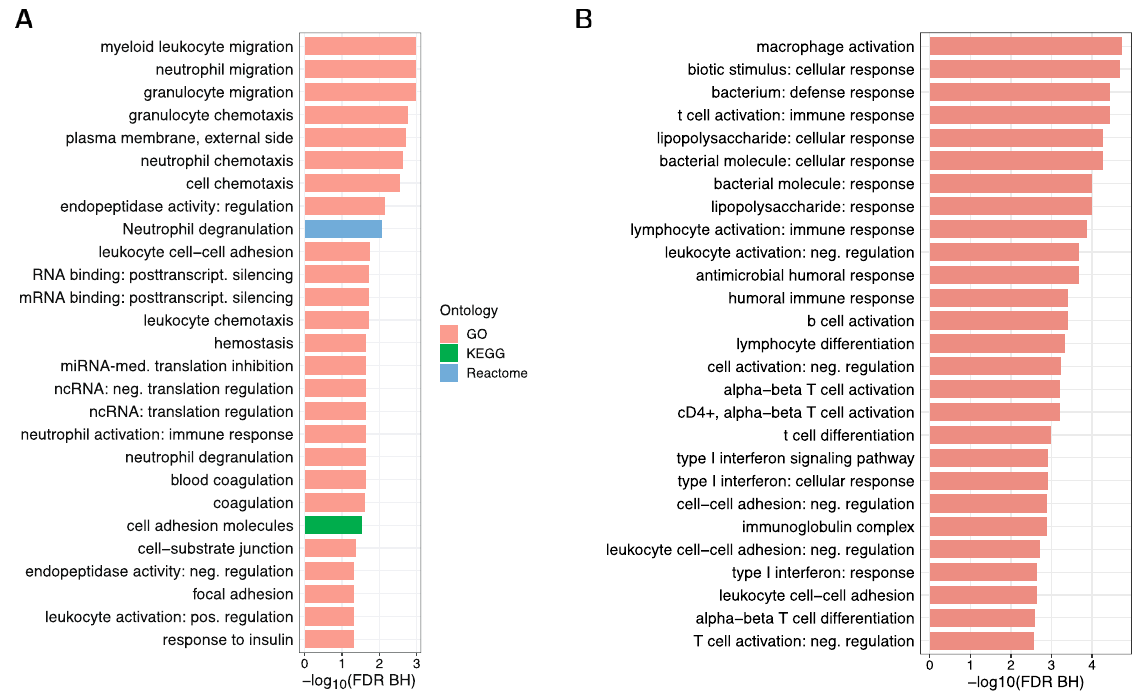
Fig. 5 Pathway enrichment results. The enrichment results of genes implicated by estimated glomerular fi ltration rate (eGFR) ( A ) and urinary albumin-to- creatinine ratio (UACR) ( B ) associated CpG sites as assessed in the Gene Ontology (GO), the Kyoto Encyclopedia of Genes and Genomes (KEGG) and Reactome databases are shown. The results passing a Benjamini-Hochberg FDR < 0.05 are shown but are limited to the top 27 pathways for